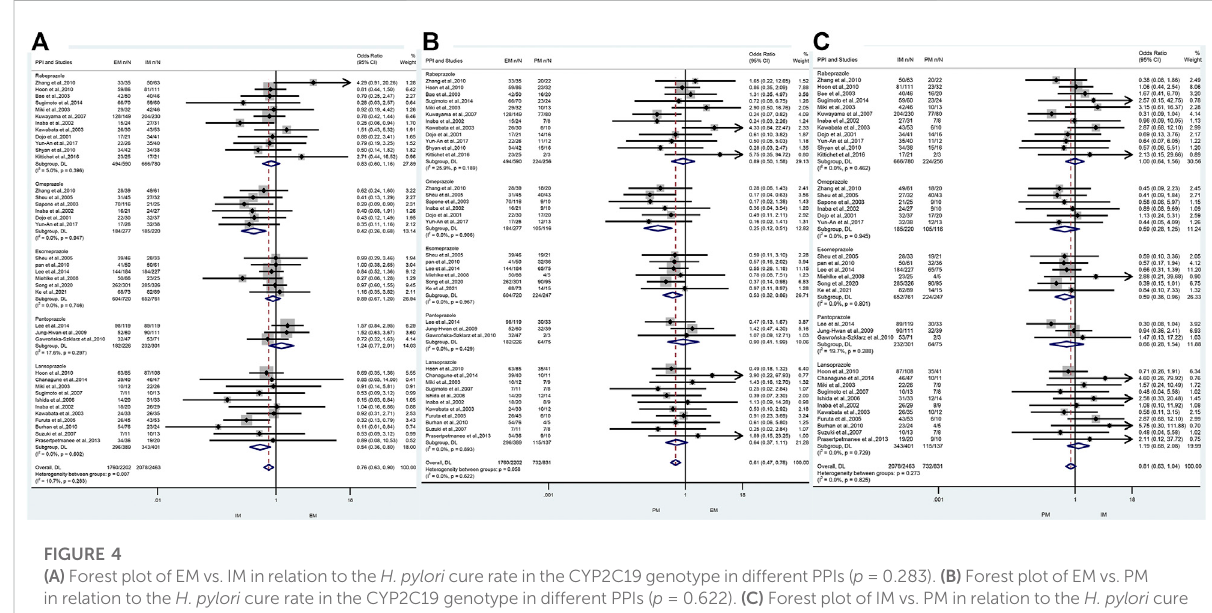
FIGURE 4 (A) ForestplotofEMvs.IMinrelationtothe H.pylori curerateintheCYP2C19genotypeindifferentPPIs( p =0.283). (B) ForestplotofEMvs.PM in relation to the H. pylori cure rate in the CYP2C19 genotype in different PPIs ( p = 0.622). (C) Forest plot of IM vs. PM in relation to the H. pylori cure rate in the CYP2C19 genotype in different PPIs ( p = 0.825). p = 0.05, signi fi cant heterogeneity or statistically signi fi cant, when appropriate. p < 0.05, random-effects model; p > 0.05, random-effects model. Symbol: , single studies included in the meta-analysis; , sample size of single studies; , con fi dence interval (CI); , overall pool estimated; , tendency; , overall pool OR.